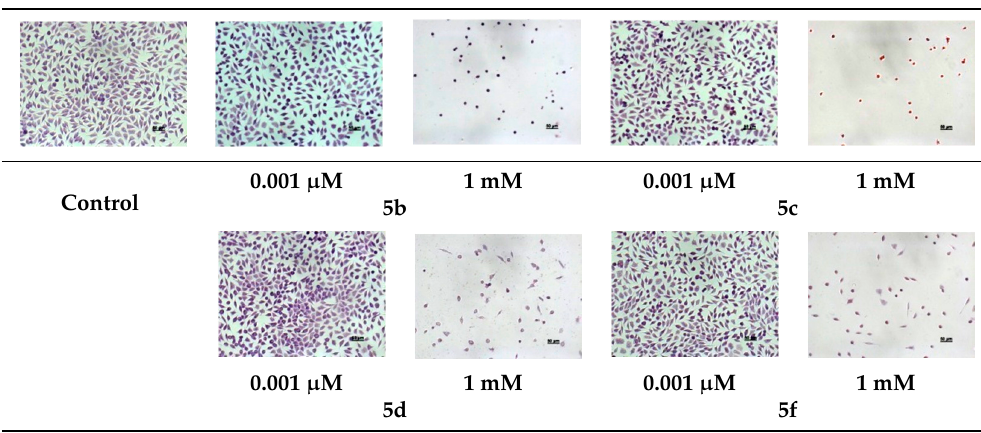
Table 2. Light micrographs of L929 fibroblast cells, untreated (Control), and treated with pyrazolo-